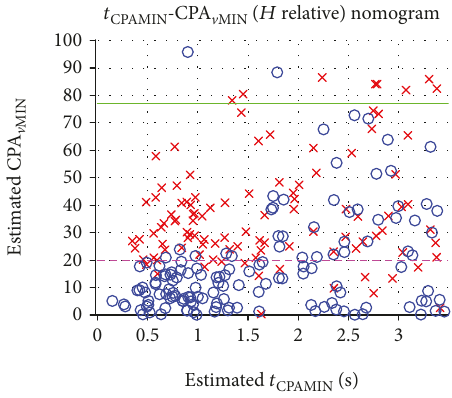
Figure 19: TTCPA-vertical CPA ( H relative) nomogram (red x: vertical far encounters; blue circle: vertical close encounters).